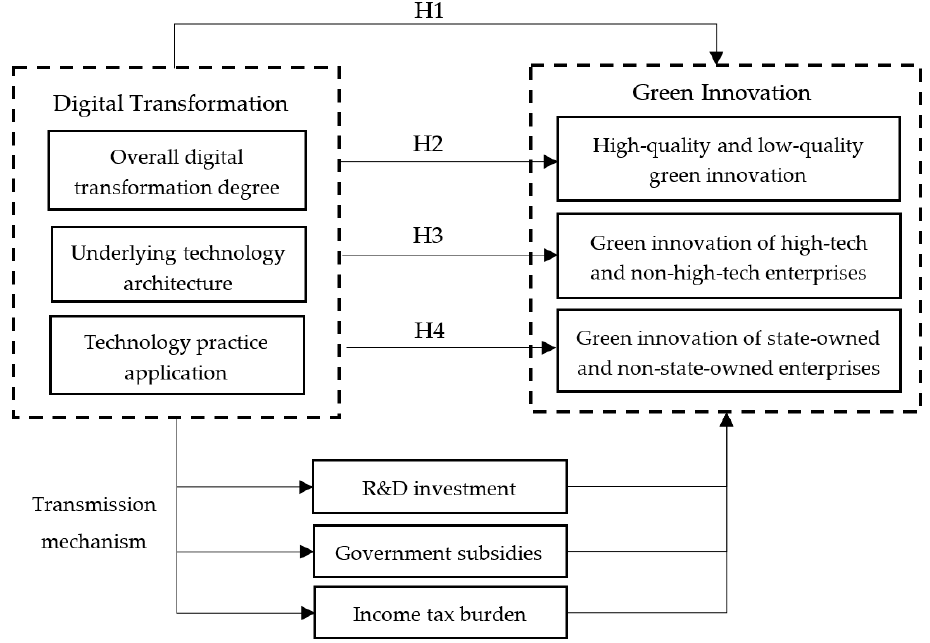
Figure 3. The research